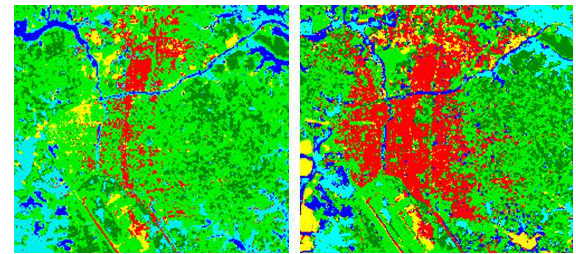
Figure 10. Urban growth in cultivated land between 2000 and 2009 (see legend Fig. 4)